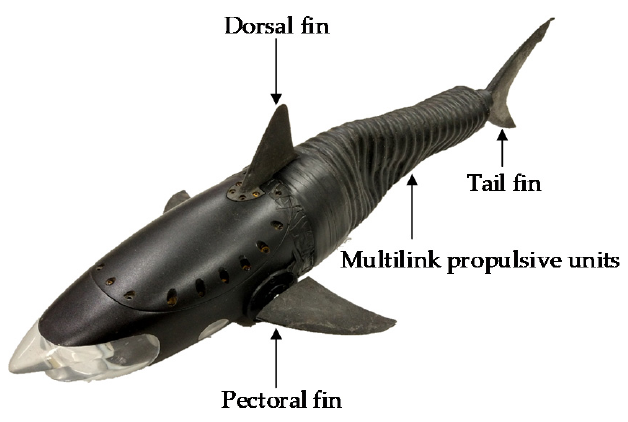
Figure 1. The shark-like robotic fish prototype [16].